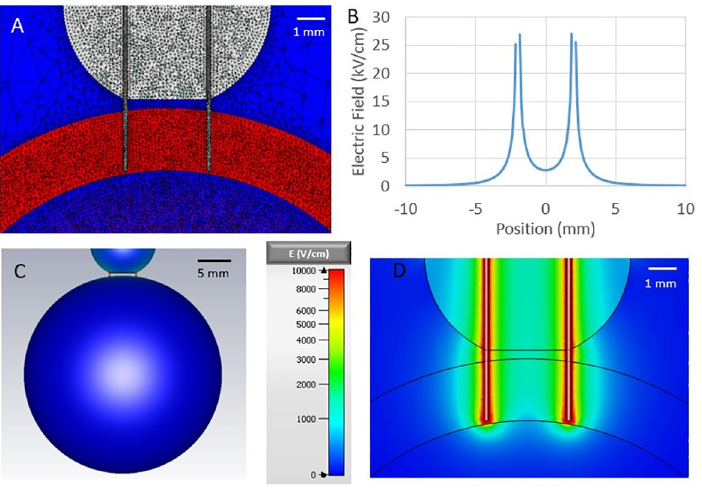
Fig 3. Electric field distribution for 1 kV applied to two needle electrodes inserted into the cardiac tissue of our simplified heart model. A) 2D mesh view of the cross section through the needle electrodes B) field strength along the line perpendicular to the long axes of the electrodes, at a tissue depth of 1.5 mm halfway between the electrodes C) 3D view of the cardiac surface and D) cross-section through needle electrodes.